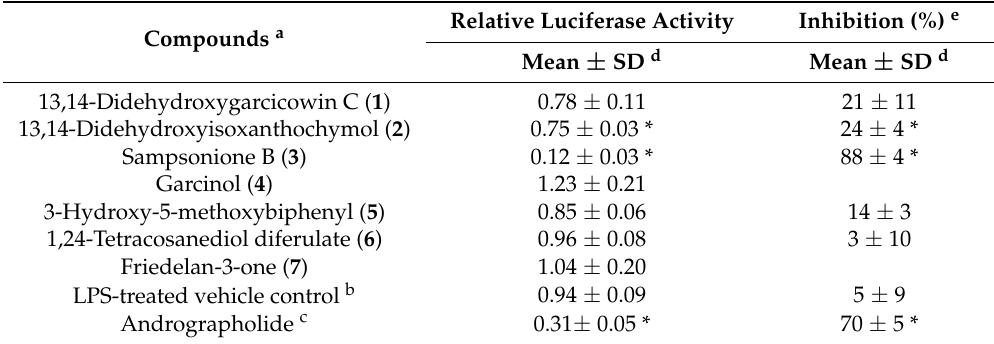
Table 2. The effects of compounds 1 – 7 from the stems of Garcinia multiflora on NF- κ B activation in RAW 264.7/Luc-P1